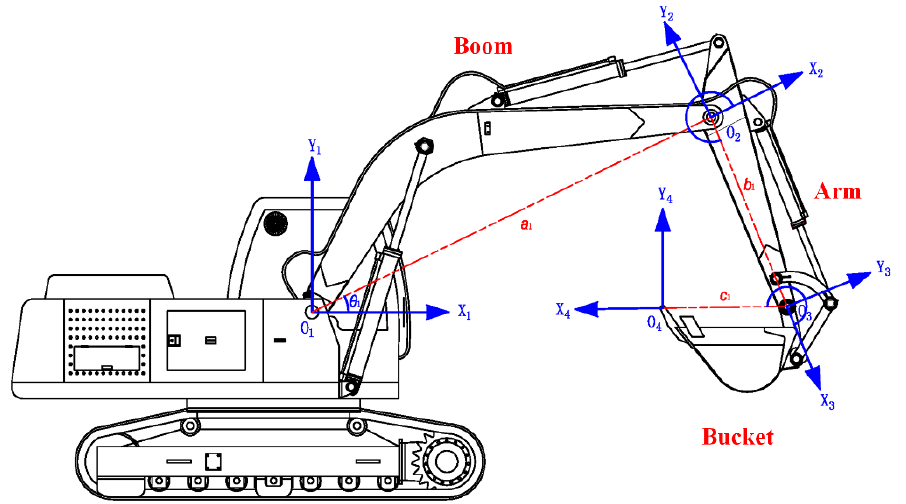
Figure 2. D-H coordinate system of excavator working device.